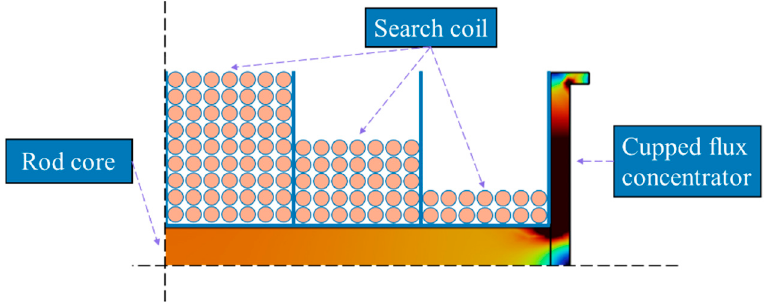
Figure 7. 2D axisymmetric GAFDEM of the winding and magnetic core.